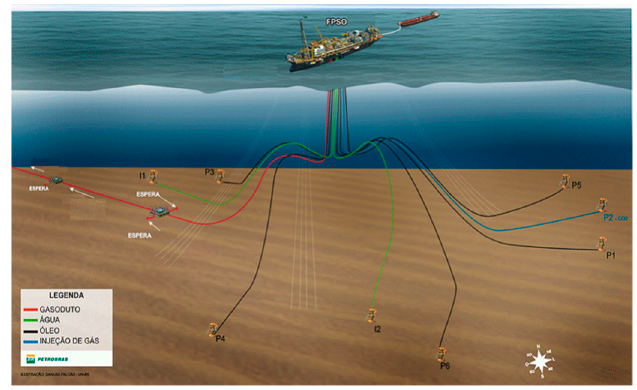
Figure 5. Typical constellation for water-alternating-gas (WAG) and CO 2 -EOR using an floating production storage and offloading (FPSO) unit. From Reference [19].